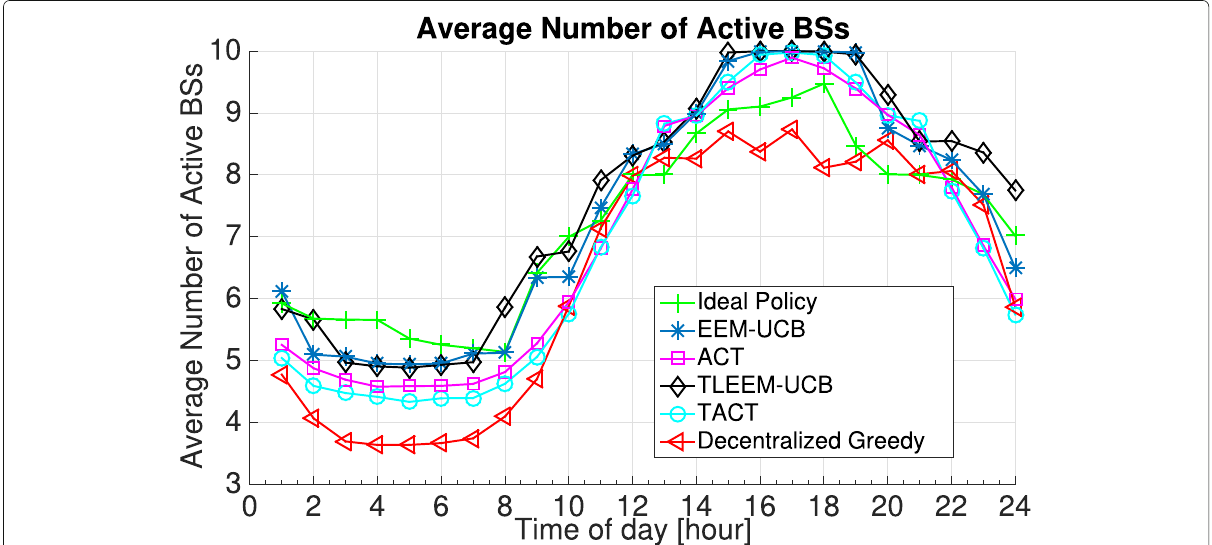
Fig. 9 Average number of active BS suggested by several learning algorithms with respect to time of day. The figure compares the average number of BS required to be switched ON achieved by several learning policies in function of daytime. The number of active BS is plotted from 1:00 am